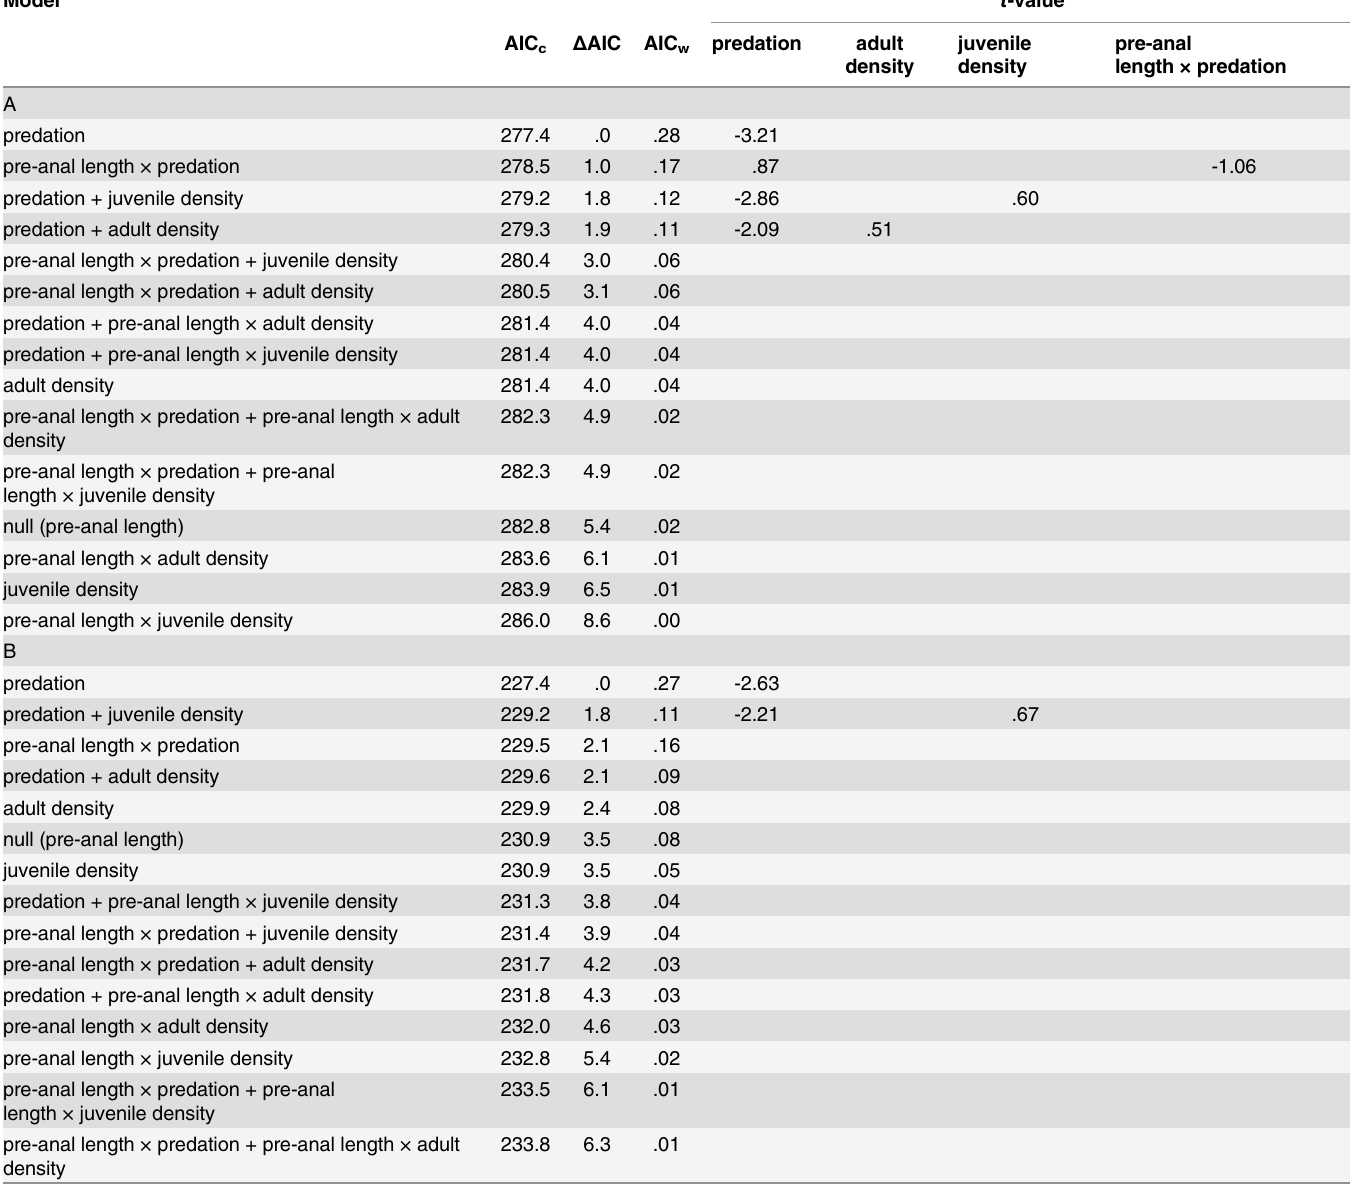
Table 1. Predictors of reproductive investment among populations of the Pacific leaping blenny. ( A ) Models that do not consider potential variation due to reproductive status among populations (i.e., only included a population random effect for pre-anal length). ( B ) Models that control for potential variation in reproductive status (i.e., included a population random effect for pre-anal length, egg stage, and their interaction). Effect sizes are represented by t -values and were considered to be statistically distinguishable effects if larger then 1.96. N females,populations = 106,5